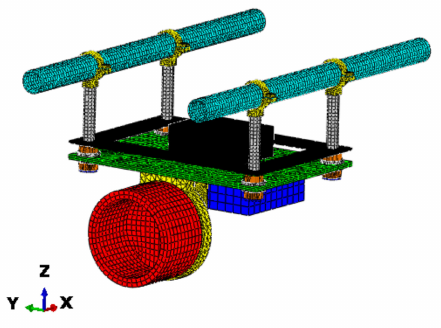
Figure 14. Finite element model of radar installation damping platform. Table 2. Material parameters of various components in the UAV LiDAR installation